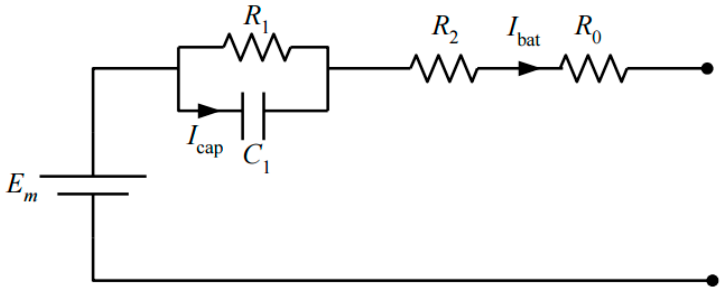
Figure 9. Simplified third order model of battery.